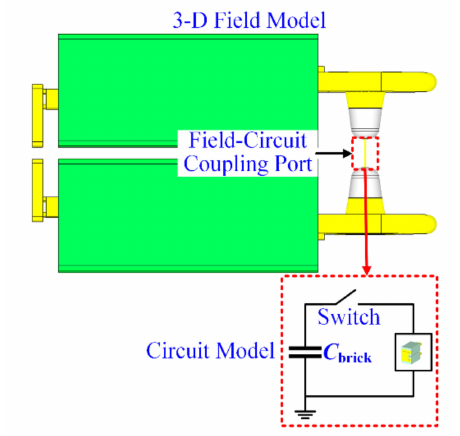
Figure 7. Schematic of the field-circuit coupling port for a single discharging brick.